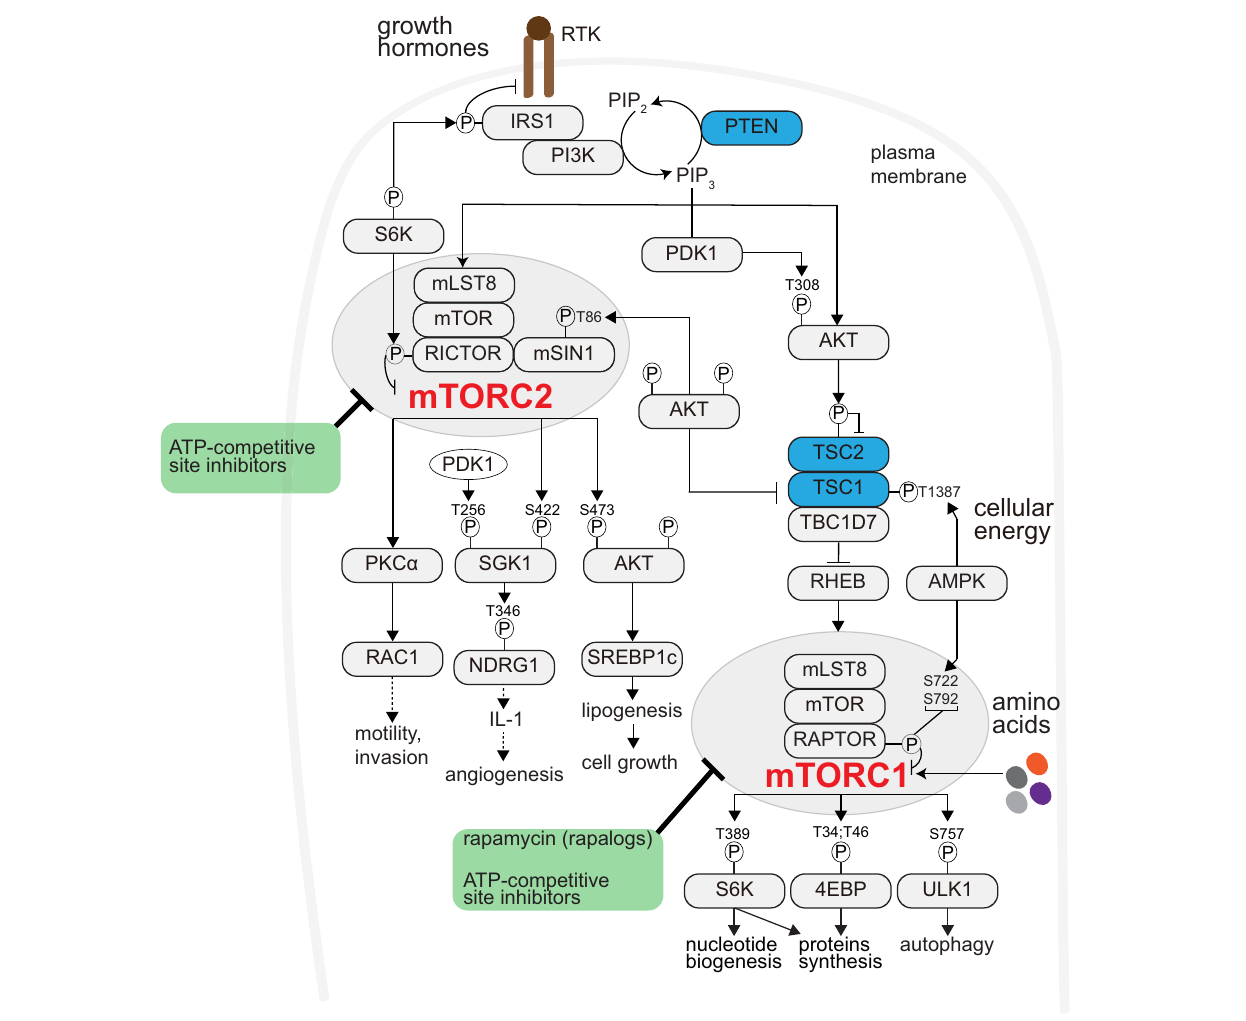
FigURe 1 | mTOR signaling promotes anabolism. Receptor Tyrosine Kinases (RTKs)- Phosphatidyl-Inositol-4,5-bisphosphate 3-Kinase (PI3K) activated by growth factor (like insulin). PI3K generates phosphatidylinositol-3,4,5-trisphosphate (PIP3) from the membrane phospholipid phosphatidylinositol-4,5-bisphosphate (PIP2). Phosphatase and Tensin Homolog Deleted on Chromosome 10 (PTEN) counteracts PI3K activity (restoring PIP3 to PIP2). PIP3 recruits to the plasma membrane and activates phosphoinositide-dependent kinase 1 (PDK1) and AKT. PDK1 phosphorylates and activates AKT (pAKT-Thr308). pAKT-Thr308 phosphorylates and inhibits the TSC complex. The TSC complex, composed of tuberous sclerosis complex 1 (TSC1) and TSC2 and TRE2-BUB2-CDC16 domain family member 7 (TBC1D7), activates the lysosomal RAS homolog enriched in brain (RHEB). RHEB interacts with and activates mTORC1. mTORC1 comprises mTOR, mammalian lethal with sec-13 protein 8 (mLST8), and regulatory-associated protein of mammalian target of rapamycin (RAPTOR). mTORC1 can also be activated by nutrients (such as amino acids). Cellular energy status also regulates mTORC1 through AMPK-mediated TSC or RAPTOR phosphorylation. mTORC1 promotes anabolism, among others, through ribosomal protein S6 kinase (S6K), eukaryotic translation initiation factor 4E (eIF4E)-binding protein 1 (4EBP1), and blocks cellular catabolism through Unc-51-like kinase 1 (ULK1). Through S6K-mediated IRS1 phosphorylation, mTORC1 negatively regulates mTORC2-AKT signaling. Rapamycin and its analogs (so-called rapalogues) acutely inhibit mTORC1 allosterically. The ATP-site competitive inhibitor(s) potently block both mTORC1 and mTORC2 signaling. mTORC2 is also activated by RTKs, and consists of mTOR, mLST8, mammalian stress-activated map kinase-interacting protein 1 (mSIN1), and rapamycin- insensitive companion of mTOR (RICTOR). mTORC2 regulates the AGC kinase family members AKT, serum/glucocorticoid-regulated kinase (SGK), and protein kinase C (PKC). Prolonged rapamycin administration may block mTORC2